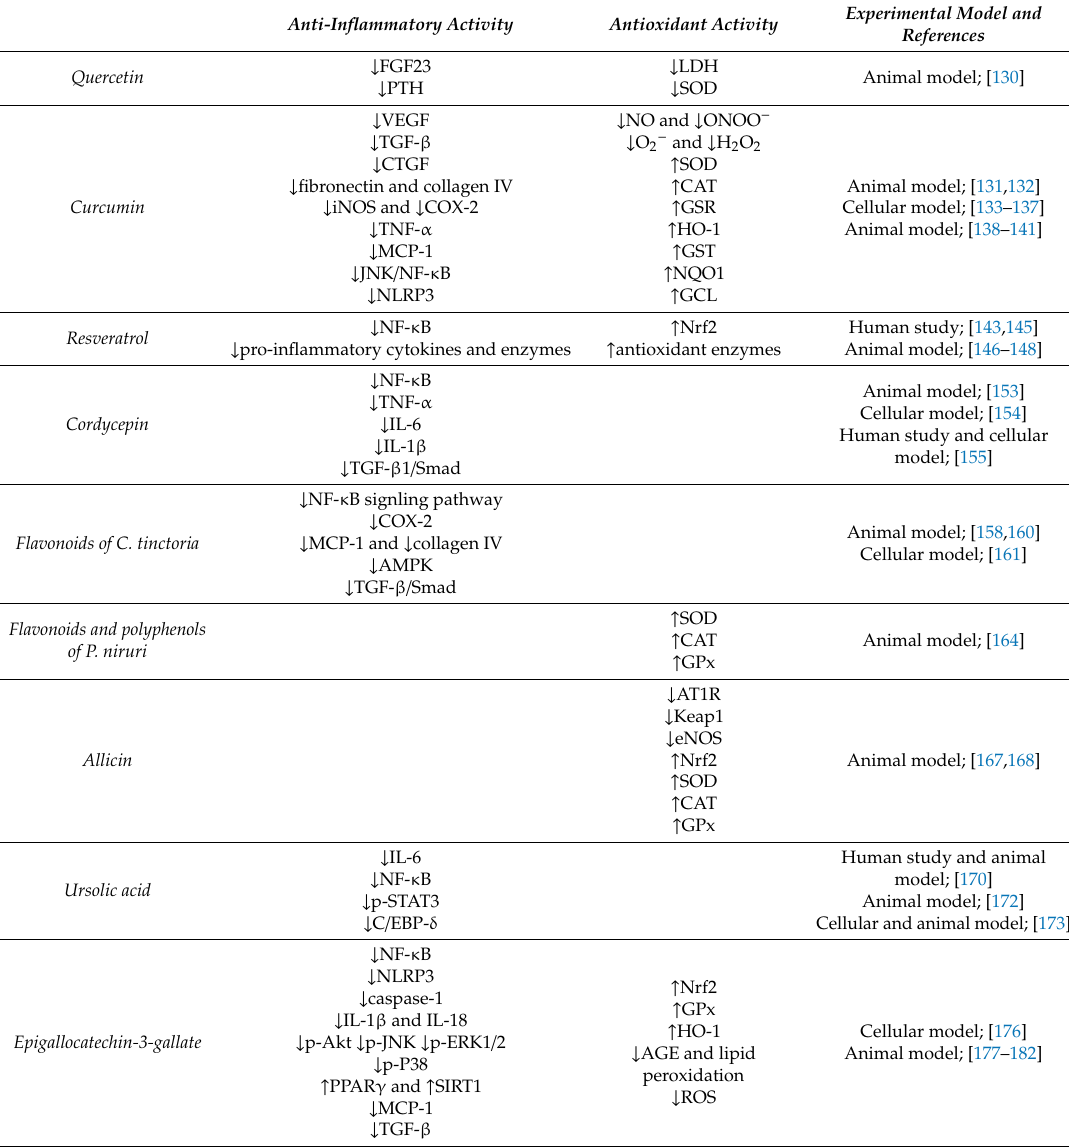
Table 2. The anti-inflammatory and antioxidant activities of the described plant-derived metabolites, with evaluation of the involved pathways which can result decreased ( ↓ ) or increased ( ↑